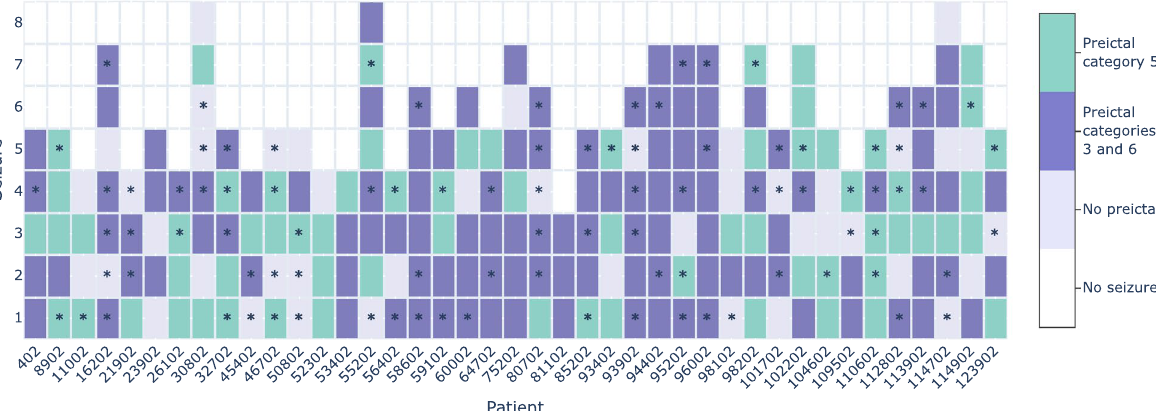
Figure 6. Results for preictal interval identification. The preictal interval was found for 37 patients (90%) and 116 seizures (51%). These results correspond to the evidence of preictal interval found for categories 3 and 6 (together) and category 5, for all groups of features. The results for category 5 were presented for a given seizure when categories 3 or 6 have not been previously assigned in any of the group of features. Asterisks indicate seizures for which preictal patterns have also been identified in a study using ECG data concurrent with the EEG data under analysis (considering that these preictal intervals started before the SPH) 26 . Preictal patterns were found in both EEG and ECG in 22% of the seizures analysed in this